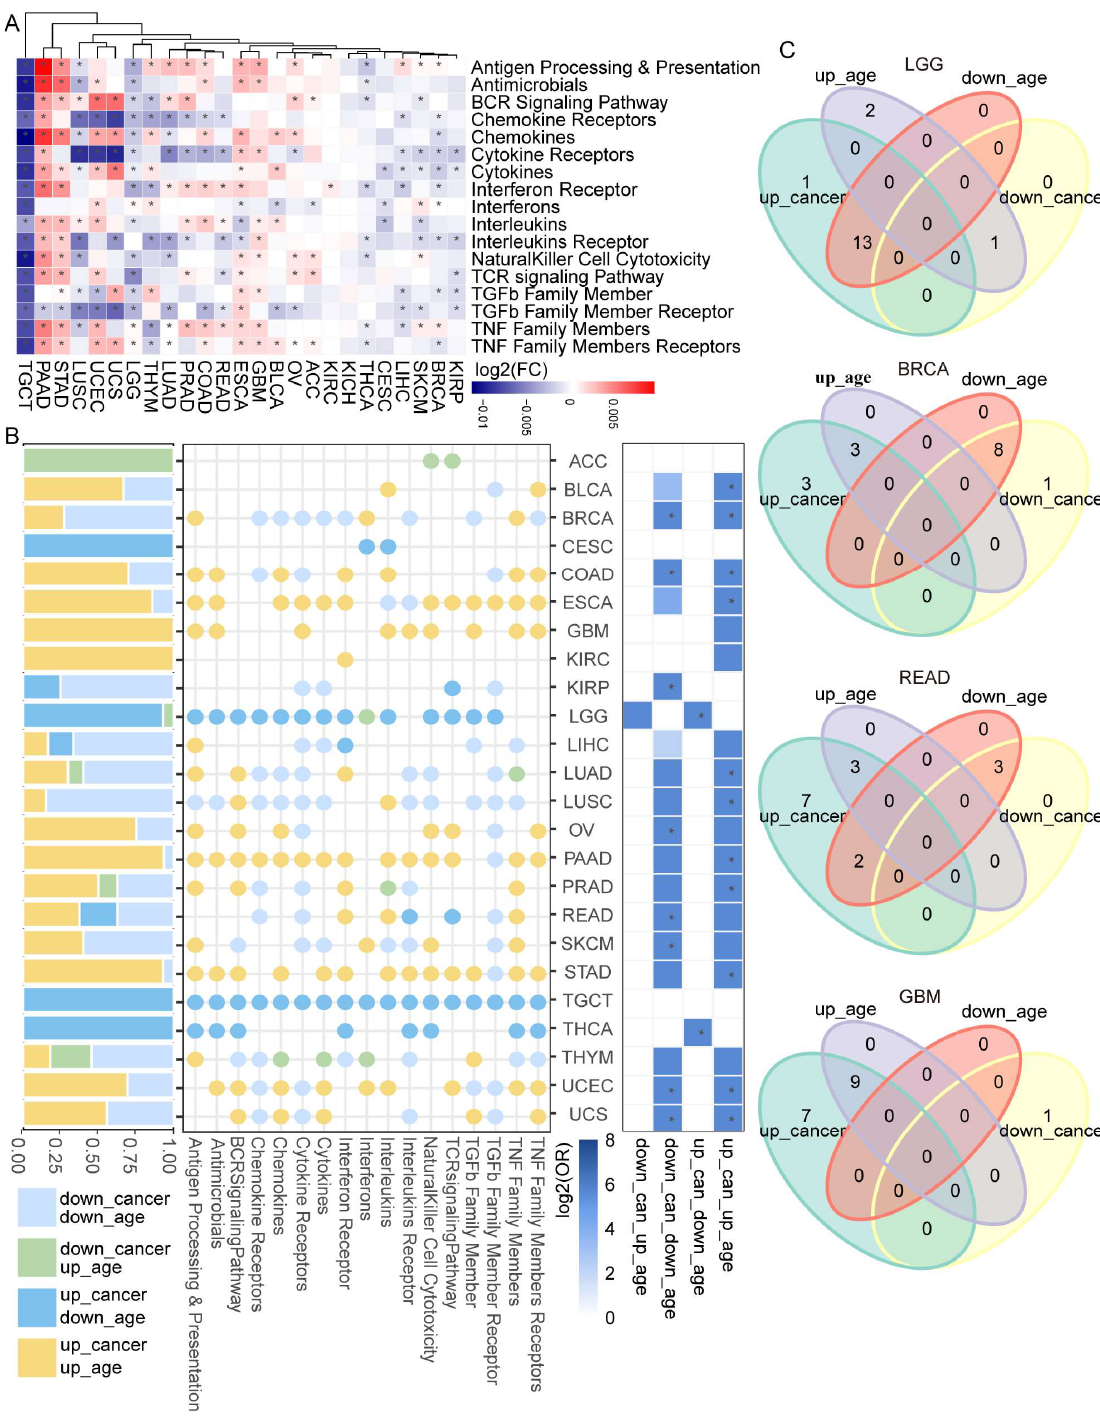
Figure 2. Immune-related pathways were dysregulated with age. ( A ) Heatmap showing IRP ex- pression level dysregulated with age across 25 cancer types. ‘*’ denotes a significant dysregulation. ( B ) Overlap between dysregulated tumor- and age- IRPs. Left, stack bar showing the proportion of 4 types of IRPs across 25 cancer types. Middle, Dotplot showing the changing directions of 17 IRPs in 25 cancers. Right, Heatmap of Fisher’s exact test, colors denote the log2 (odds ratio) value. ( C ) Venn diagrams showing the overlap between dysregulated tumor- and age-